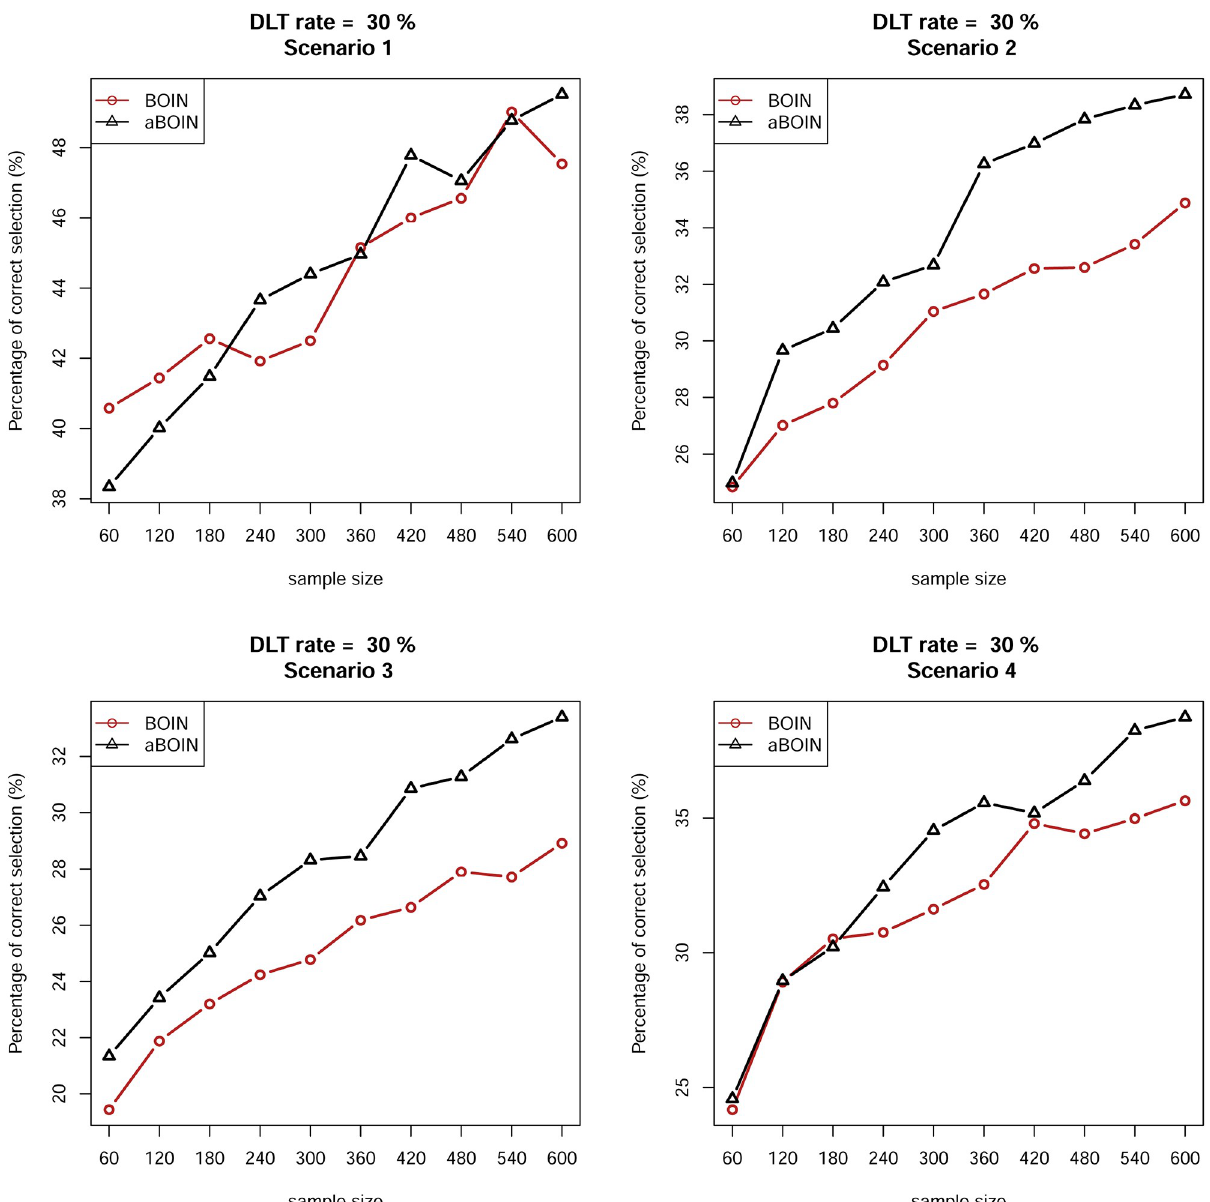
Fig 4. Correctly selected percentage of the maximum tolerated dose for the first four scenarios in the right panel at a DLT rate of 30% in Table 2 by using original BOIN and aBOIN designs in a large sample.